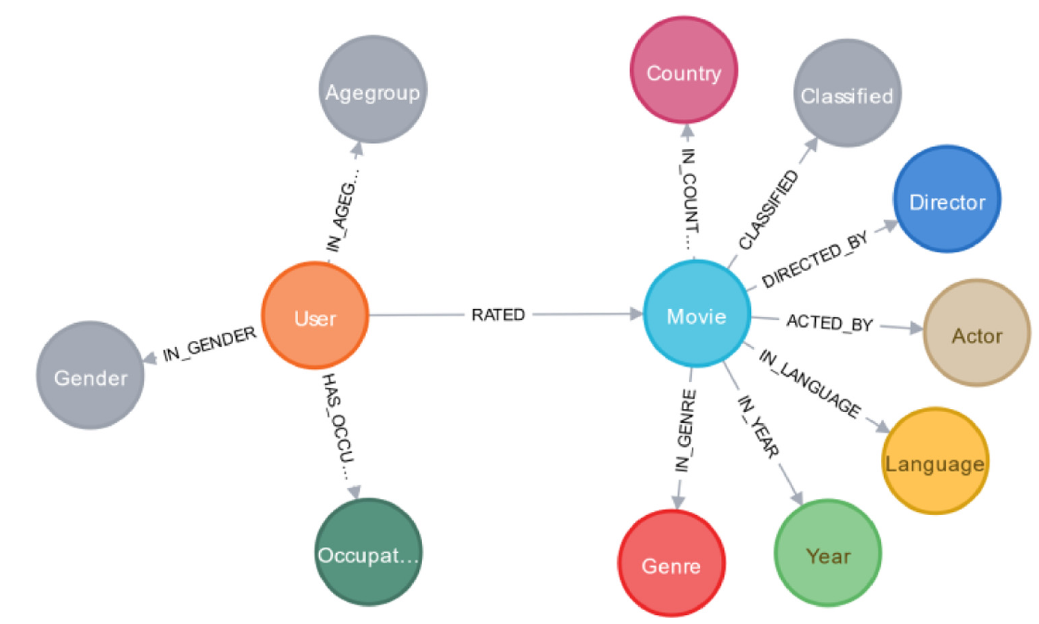
Figure 2. Ontology constructed based on the MovieLens dataset.